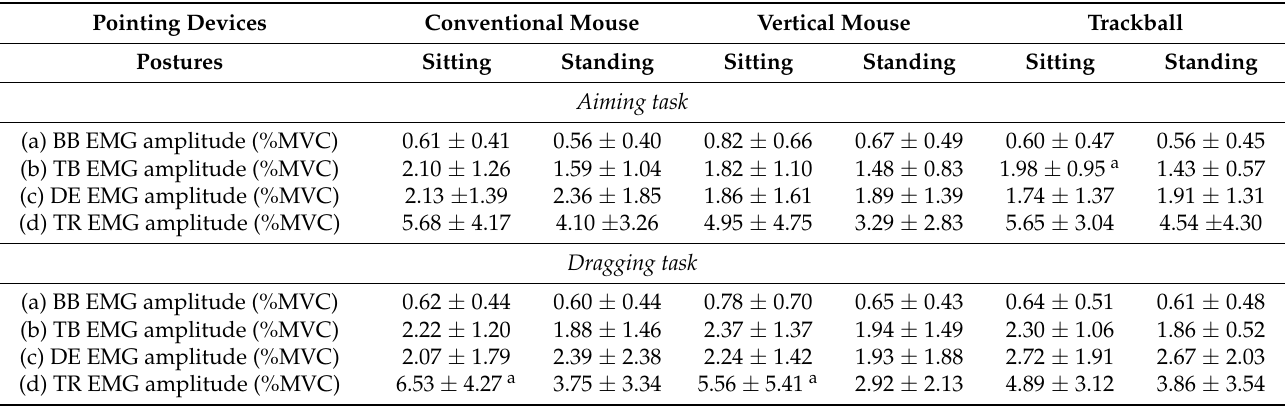
Table 1. EMG amplitude results of (a) BB, (b) TB, (c) DE, and (d) TR muscles for each pointing device by working